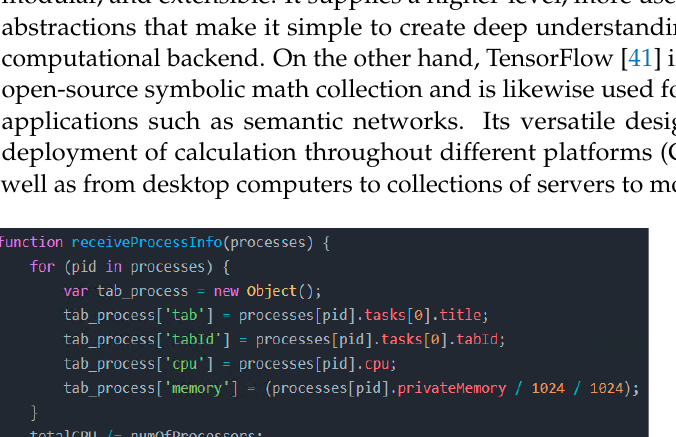
Figure 10. Obtain CPU usage and memory usage.